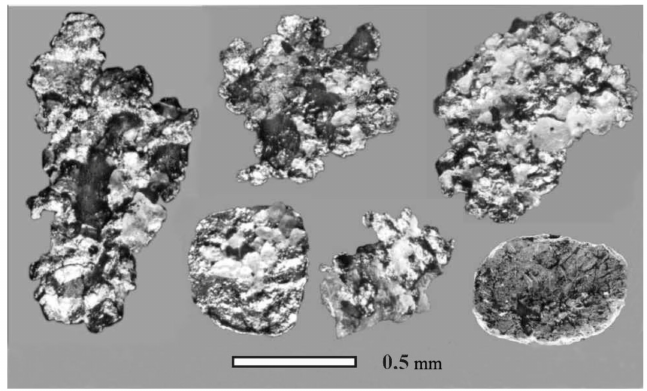
Figure 15. Pseudo-gold